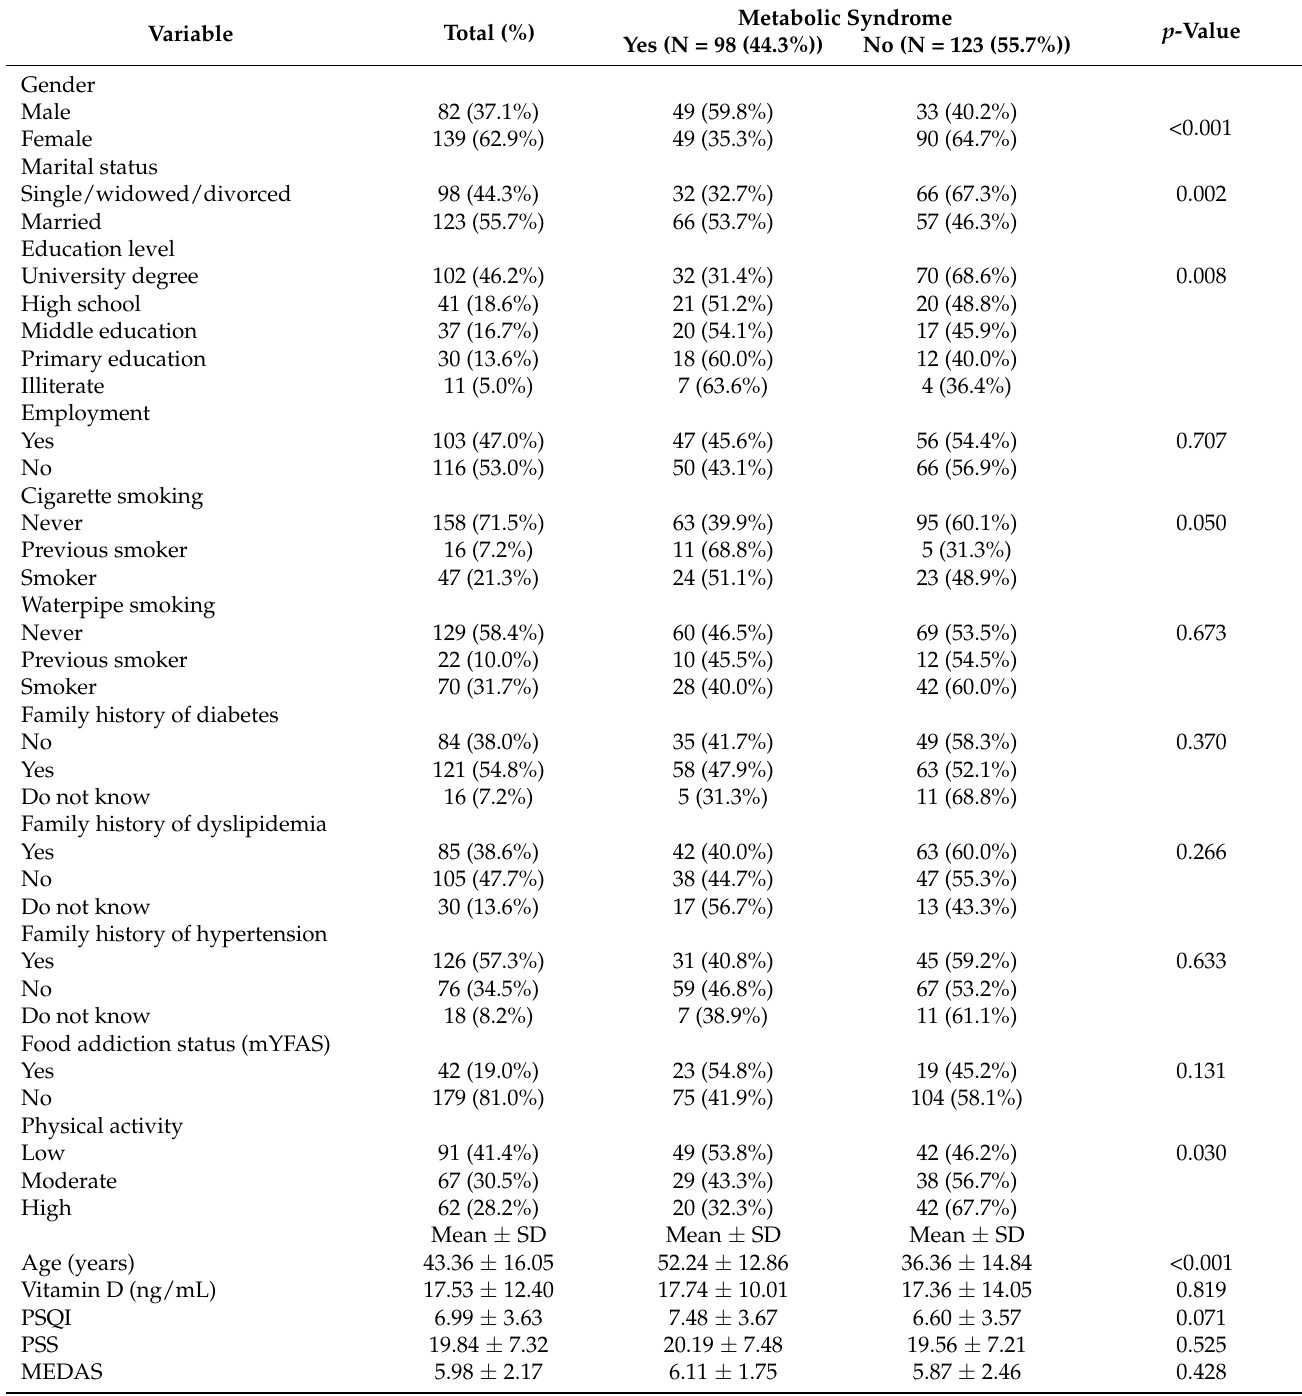
Table 1. Sociodemographic and medical characteristics of the participants (N =